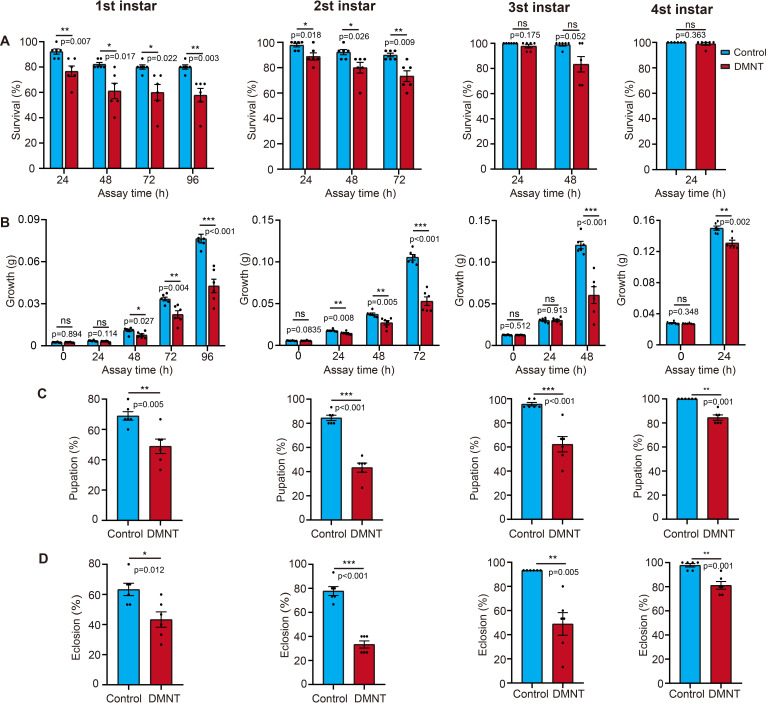
(3E)-4,8-Dimethyl-1,3,7-nonatriene (DMNT) treatment affects P. xylostella larvae of different ages.First- to fourth-instar P. xylostella larvae were tested. (A) Survival rate. (B) Body weight. (C) Pupation rate. (D) Eclosion rate. Error bars represent the standard error of six biological replicates, with 15 P. xylostella larvae per replicate. Asterisks indicate significant differences (*p<0.05, **p<0.01, ***p<0.001; ns, not significant; two-tailed unpaired t-test).
Figure 1—figure supplement 4—source data 1.(3E)-4,8-Dimethyl-1,3,7-nonatriene (DMNT) treatment affects P. xylostella larvae of different ages.